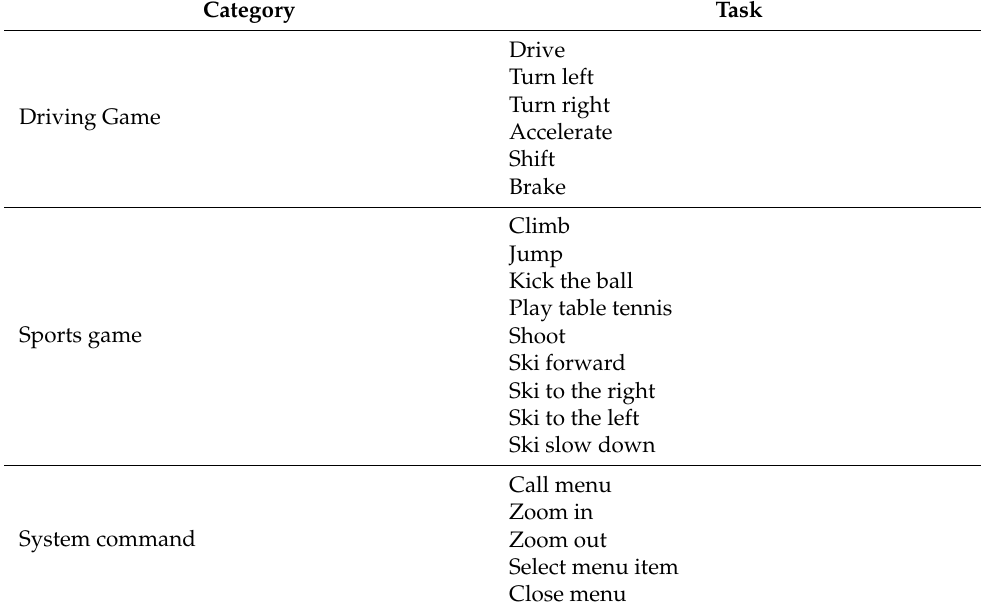
Table 2. Twenty basic